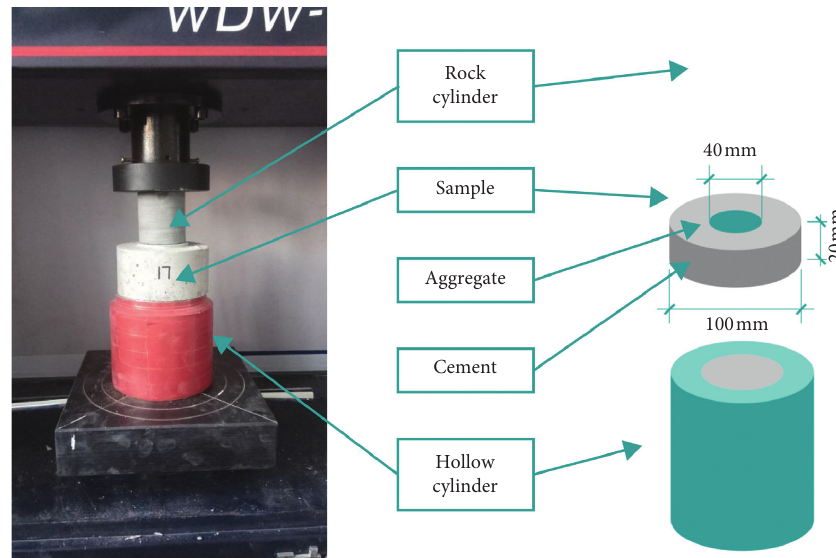
Figure 2: Setup for testing shear strength of the ITZ.